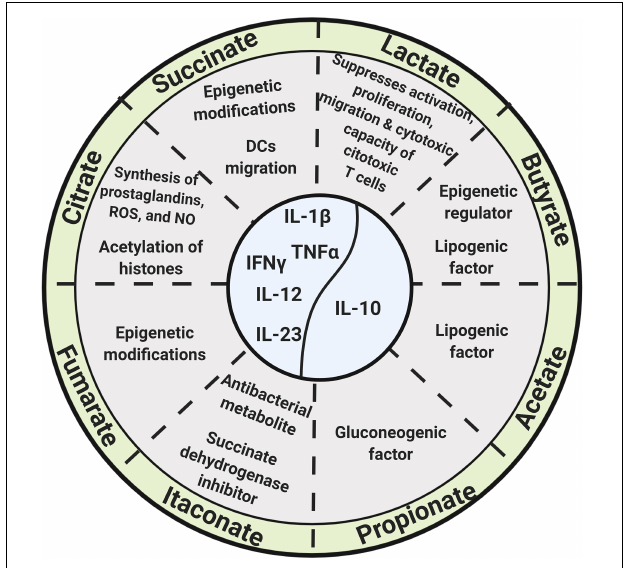
FIGURE 2 | Glycolysis and Krebs cycle-derived metabolites, as well as microbiota-derived metabolites, exert biological functions beyond energetic and biosynthetic